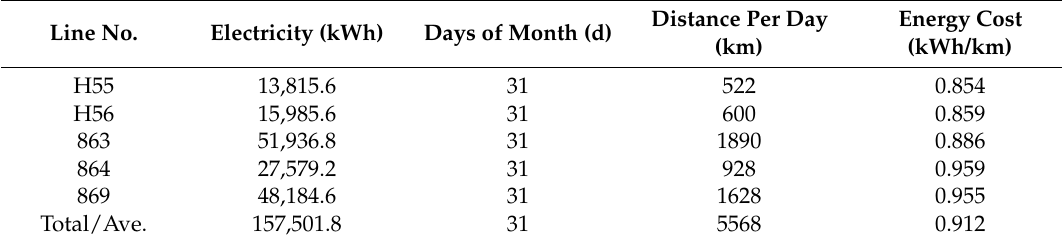
Table 3. The energy consumption of each